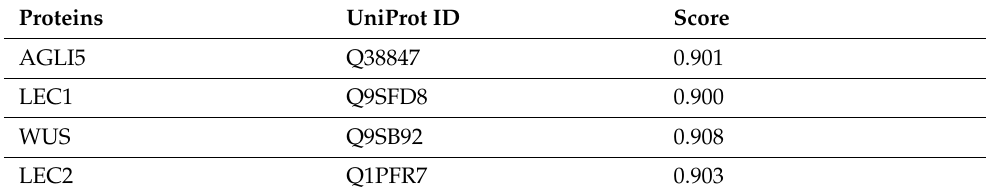
Table 1. Primary partners of BBM, their Uniprot IDs, and interaction score from the String database.